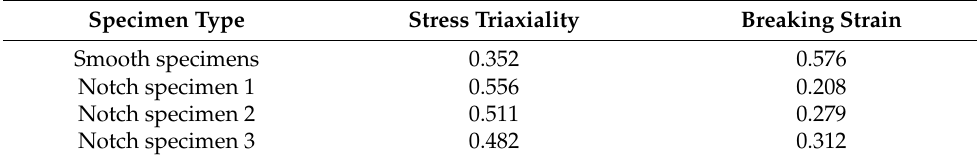
Table 3. Stress triaxiality and equivalent plastic strain of each specimen.